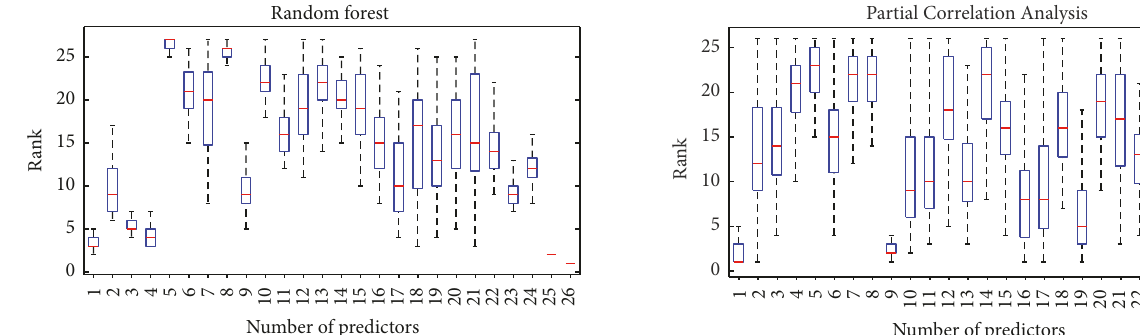
Figure 5: Rank of relative importance of predictors in the 61 sta- tions.